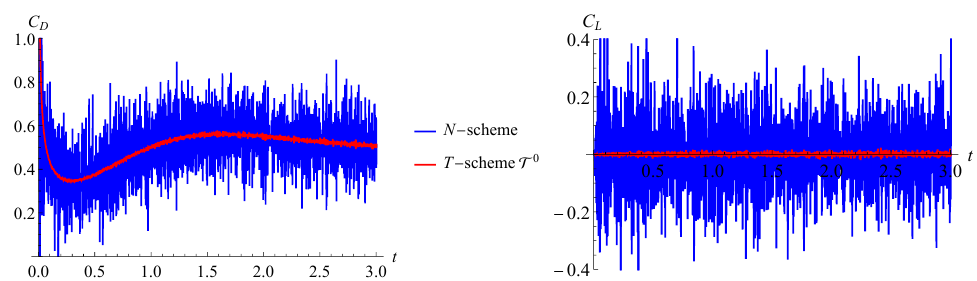
Figure 7. Calculated hydrodynamic load oscillations for flow simulation around impulsively starting cylinder: the N -scheme and scheme T 0 ; Re = 200.